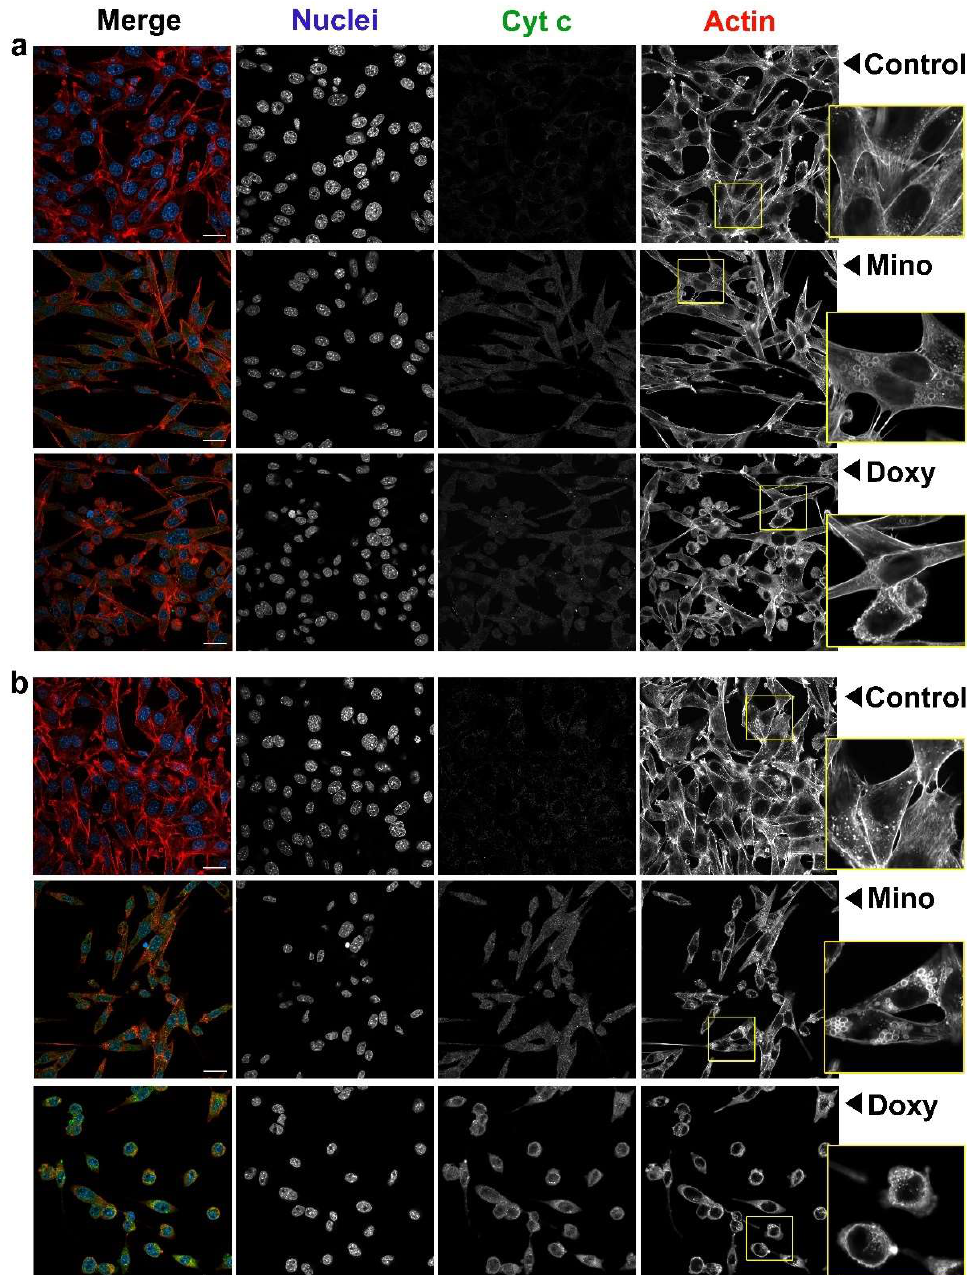
Figure 9. Imaging with confocal microscopy of C32 amelanotic melanoma cells treated with 400 µM minocycline and doxycycline for 24 h ( a ) and 48 h ( b ). Photographs present merged images as well as separate channels for nuclei, cytochrome c, and actin filaments. Scale bar 25 µM.